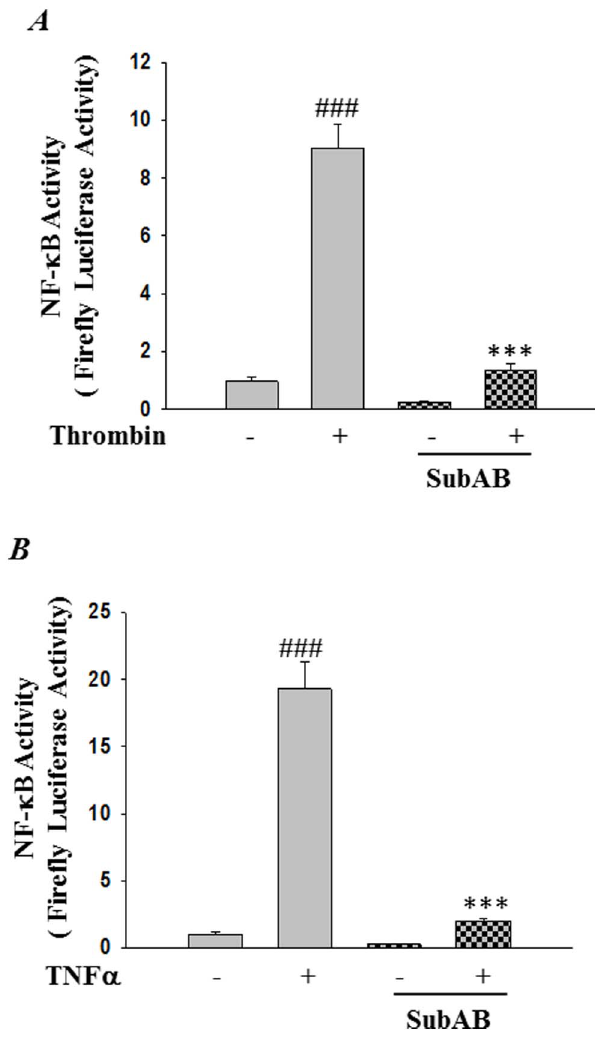
Figure 10. SubAB inhibits NF- k B transcriptional activity. HPAEC were transfected with NF- k BLUC construct by using DEAE-dextran as described in Materials and Methods. After 24 hours cells were treated with 0.1 m g/ml of SubAB or mutant SubA A272 B for 6 h, followed by treatment with ( A ) thrombin (5 U/ml) or ( B ) TNF a (100 U/ml) for 6 h. Cell extracts were prepared and assayed for Firefly and Renilla luciferase activities. The data were expressed as a ratio of Firefly to Renilla luciferase activities. Data are means 6 SE (n=4–6 for each condition). ### p , 0.001 difference from controls; *** p , 0.001 difference from thrombin and TNF- a stimulated